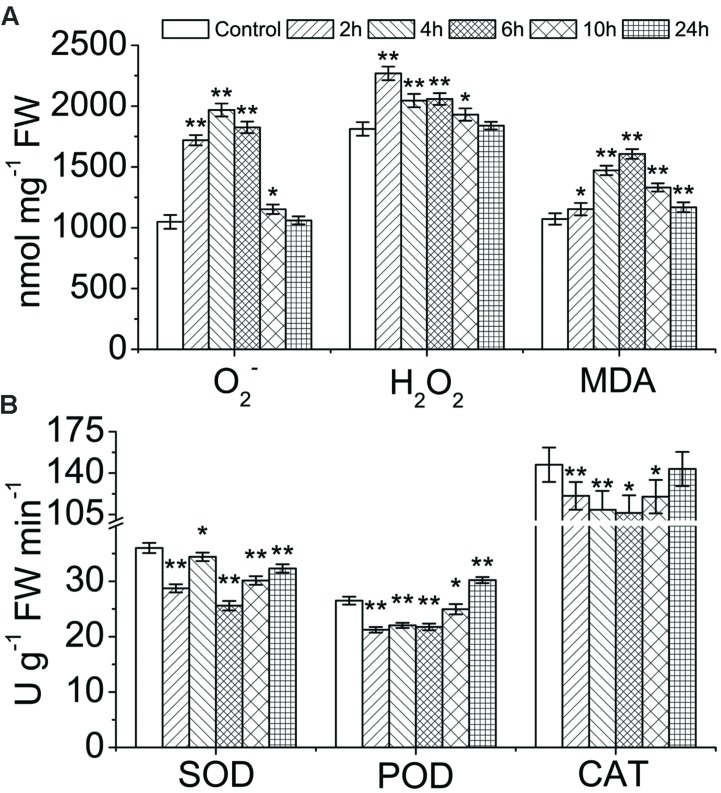
Assessment of ROS content and oxidative stress analysis in wheat flag leaves under chemical hybridizing agent (CHA)-SQ-1 treatment conditions. (A) The generation rate of O2- and content of H2O2 in control wheat flag leaves and CHA-SQ-1 treated flag leaves; content of malonaldehyde (MDA) in control and CHA-SQ-1 treated flag leaves. (B) Activities of superoxide dismutase (SOD), guaiacol peroxidase (POD) and catalase (CAT) in control and CHA-SQ-1 treated flag leaves. Data are means ± SD of three independent experiments (biological replicates). The significant of differences was assessed by Student’s t-test (∗P < 0.05, ∗∗P < 0.01).